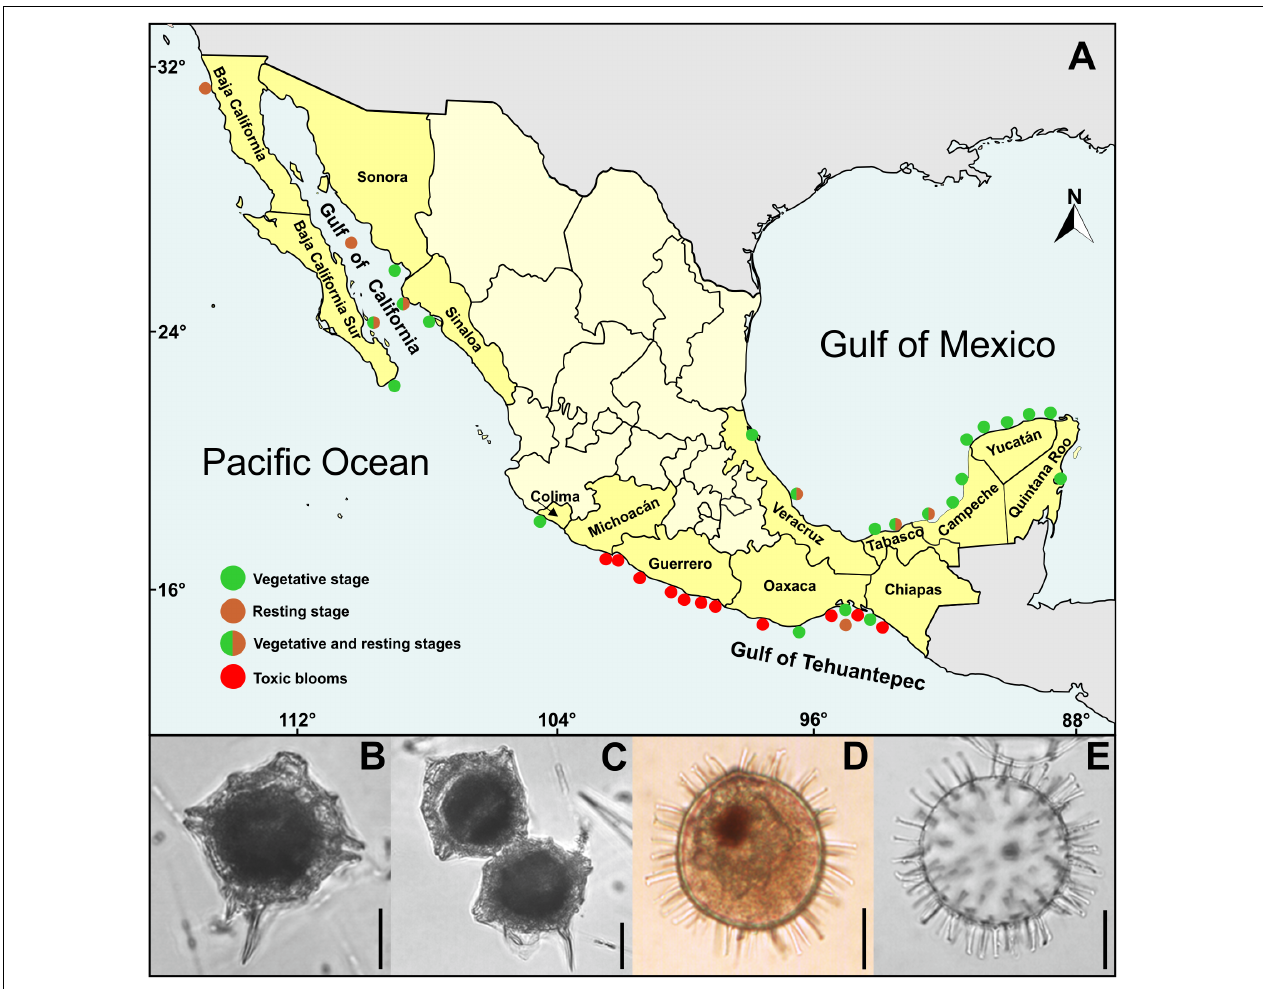
FIGURE 1 | Pyrodinium bahamense in Mexico: (A) Distribution map based on data documented by: Osorio-Tafall (1942); Martínez-Hernández and Hernández-Campos (1991); Saldate-Castañeda et al. (1991); Cortés-Altamirano et al. (1993); Gómez-Aguirre (1998a,b); Ronsón-Paulin (1999); Peña-Manjarrez et al. (2001, 2005); Licea et al. (2004); Terán-Suárez et al. (2006); Martínez-López et al. (2007); Morquecho (2008); Vásquez-Bedoya et al. (2008); Limoges et al. (2010, 2013); Gárate-Lizárraga and González-Armas (2011); Gárate-Lizárraga et al. (2011, 2013); Meave-del Castillo et al. (2012); Morquecho et al. (2012); Merino-Virgilio et al. (2014); Poot-Delgado et al. (2014); Alonso-Rodríguez et al. (2015); Maciel-Baltazar (2015); Poot-Delgado (2016); Campos-Campos et al. (2017), and Cuellar-Martínez et al. (2018). (B) Solitary vegetative cell. (C) Paired vegetative cells. (D) Whole living cyst with red accumulation body. (E) Empty cyst showing chorate processes. Scale bars = 20 µ